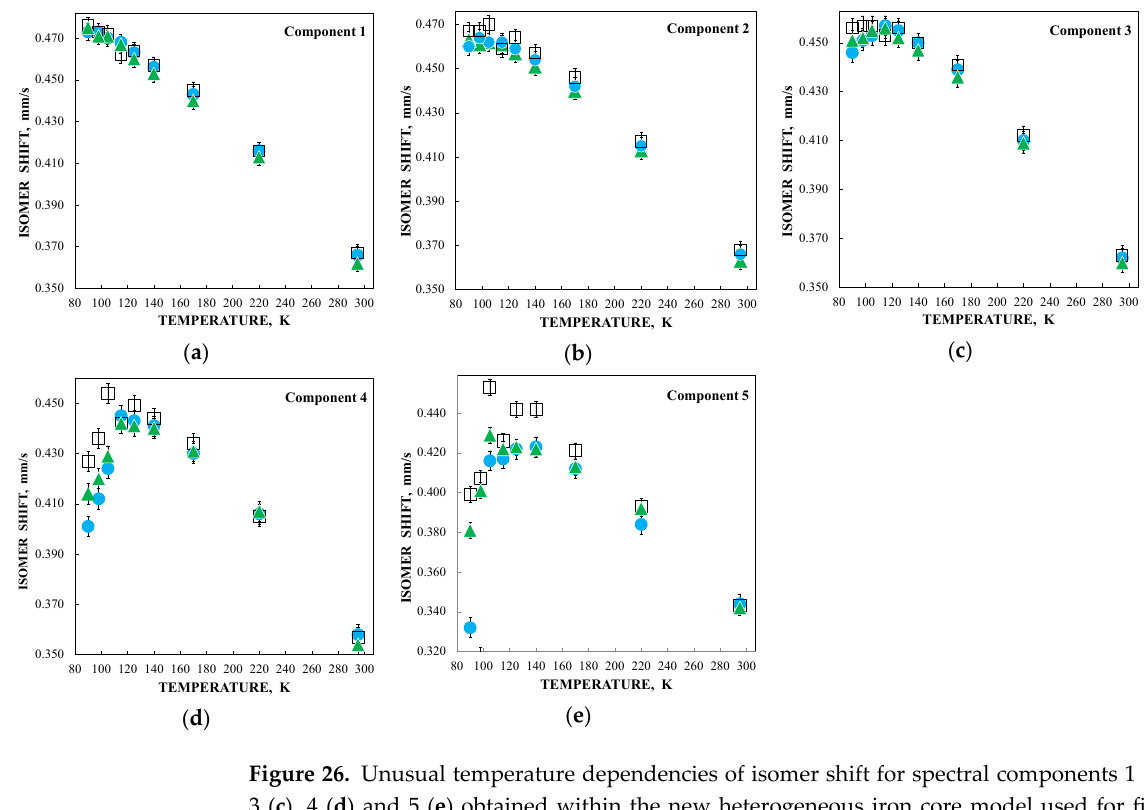
Figure 25. Zero ‐ field ‐ cooled (ZFC) and field ‐ cooled (FC) curves for the iron cores in Ferrum Lek ( a ), Maltofer ® ( b ) and Ferrifol ( c ). Indicated temperatures are the blocking temperatures T B for the largest iron cores (~35, ~40 and ~33 K) and the mean blocking temperatures (~15–14 K). Adapted from Ref. [50] with permission from Springer Nature: Hyperfine Interactions, “Unusual tempera ‐ ture dependencies of Mössbauer parameters of the nanosized iron cores in ferritin and its phar ‐